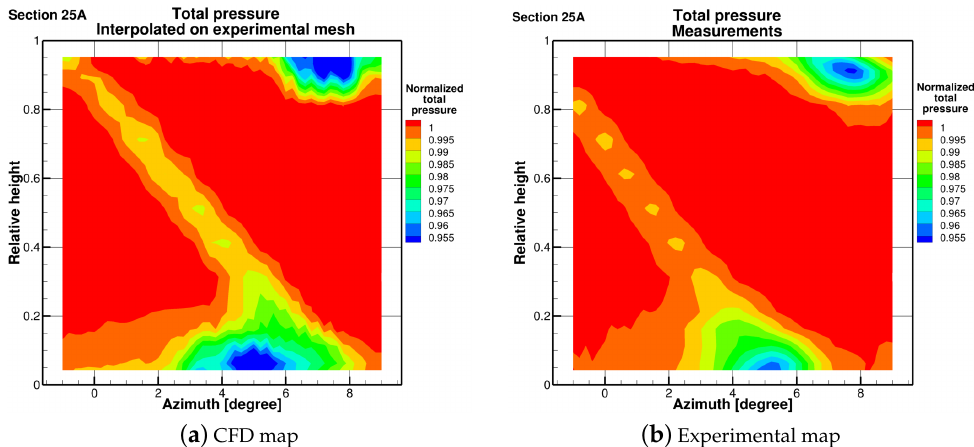
Figure 2. 2D cartographies in plane